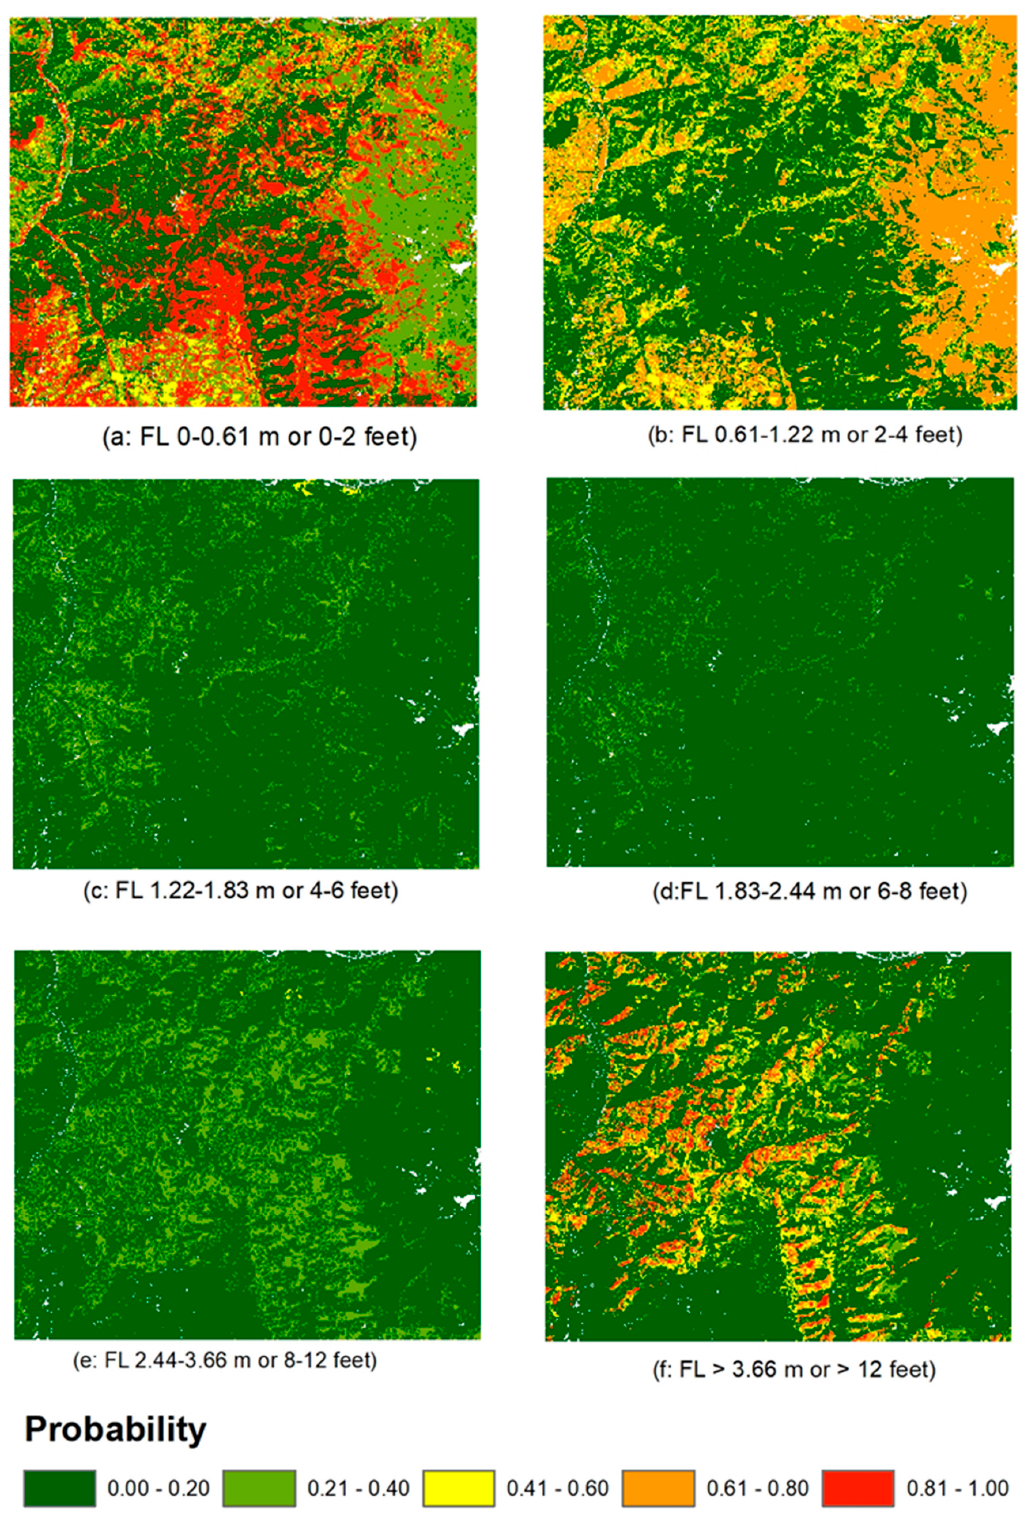
Figure 4. The probability of fire falling into each flame length category, represented by panel ( a ) through ( f ), based on Flep-Gen results, i.e., “FL 2.44–3.66 m” represents a flame length >2.44 m and ≤ 3.66 m.